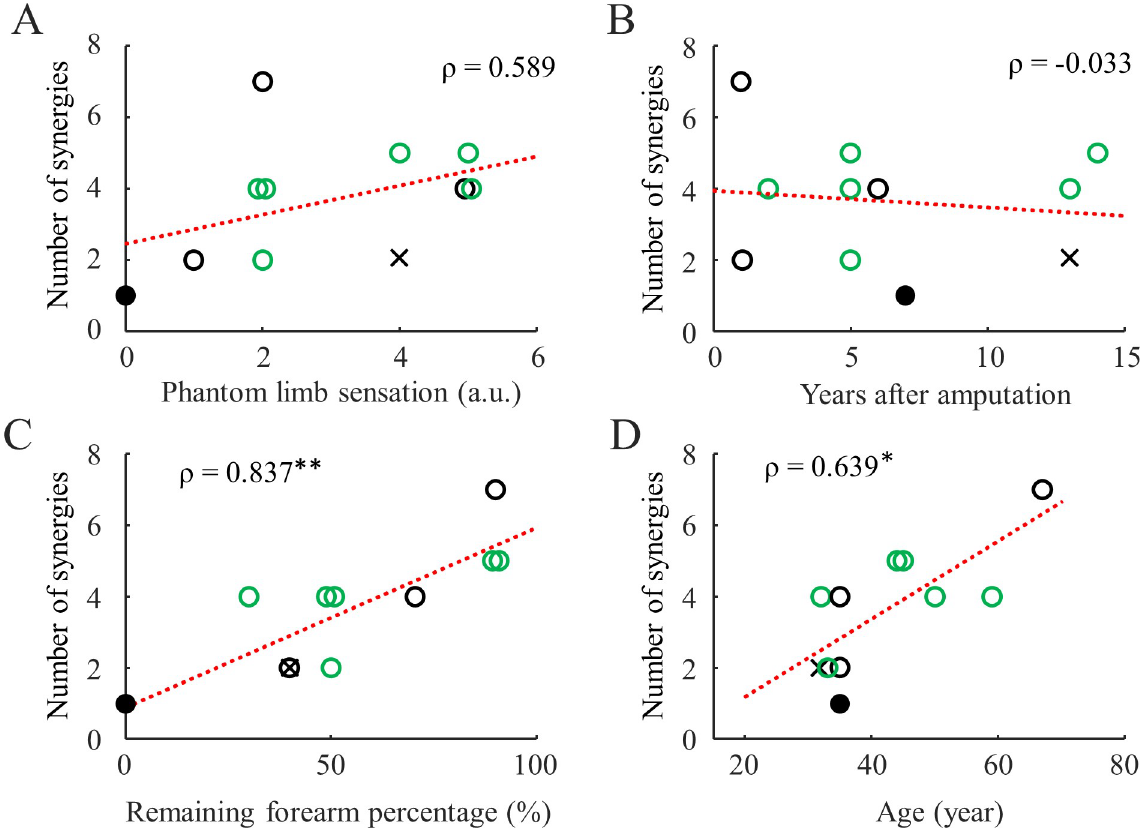
Fig 2. Relation between clinical parameters and number of synergies in amputee subjects (DB3). The red dashed lines are the linear fit lines for all subjects. Spearman’s coefficient is shown on the side. The filled circle and cross represent Sub7 (zero remaining forearm) and Sub6 (8 electrodes), respectively. The green circles represent myoelectric device users. Single asterisk and double asterisks indicate p < 0.05, and p < 0.01